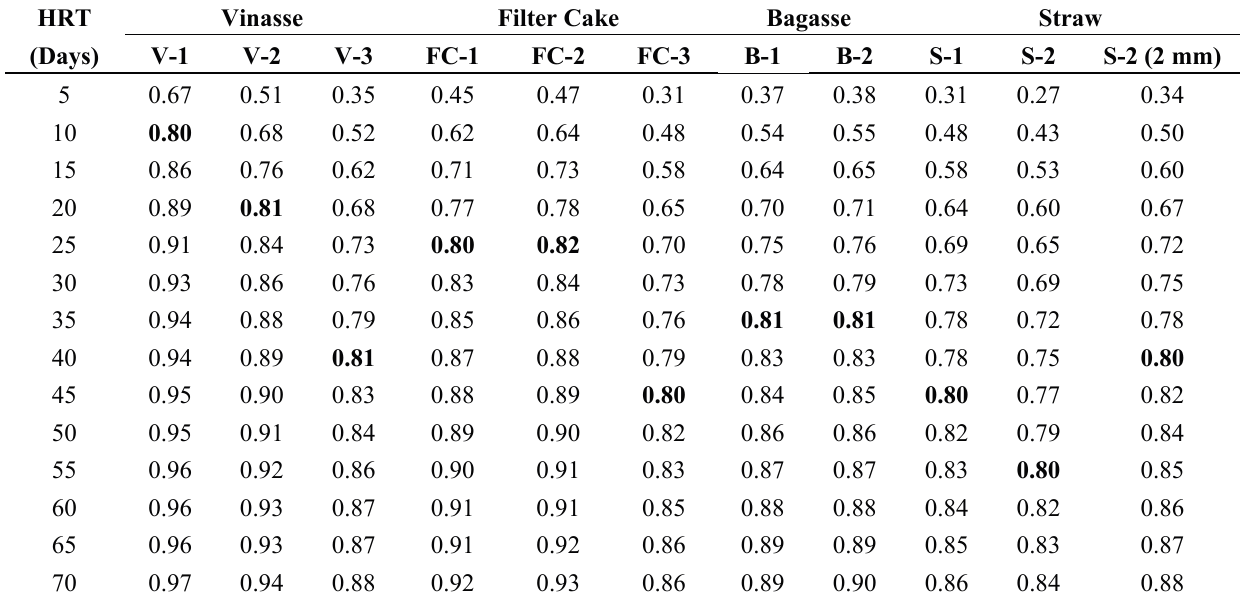
Table 5. Simulation of the hypothetical substrates conversion using CSTR system. Filter Cake